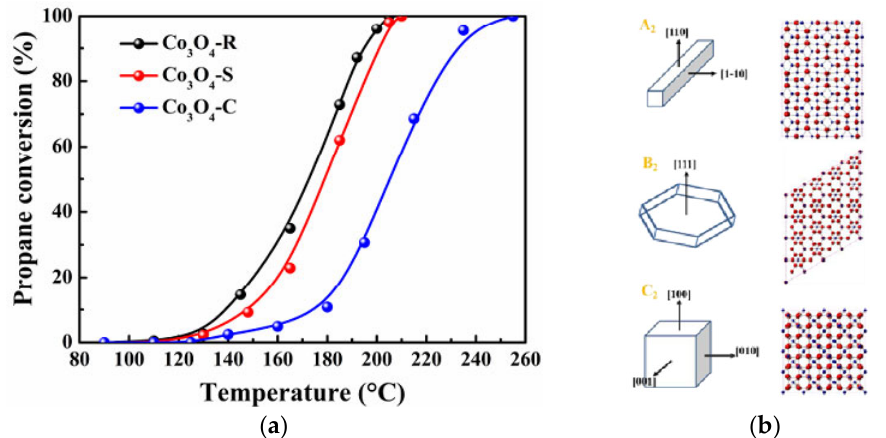
Figure 6. ( a ) Ignition curves of different catalysts for propane oxidation. ( b ) Corresponding geometric models of Co 3 O 4 (A2, B2, and C2) and surface atomic structure models of (110), (111), and (100) facets. Reprinted and adapted with permission from Ref. [70]. Copyright 2021 Elsevier.